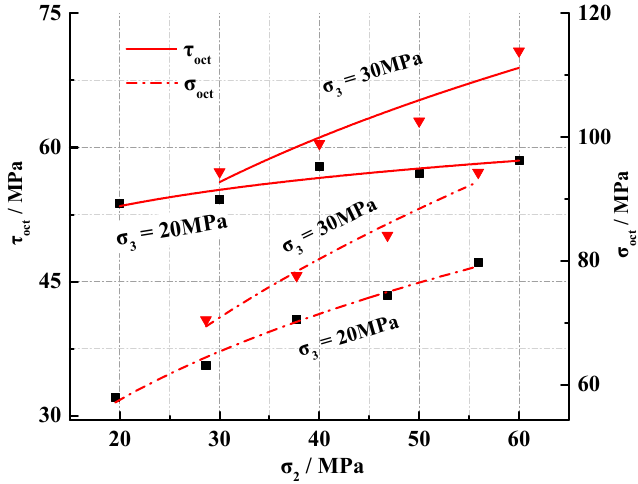
Figure 5. Relationships between τ oct , σ oct , and σ 2 .